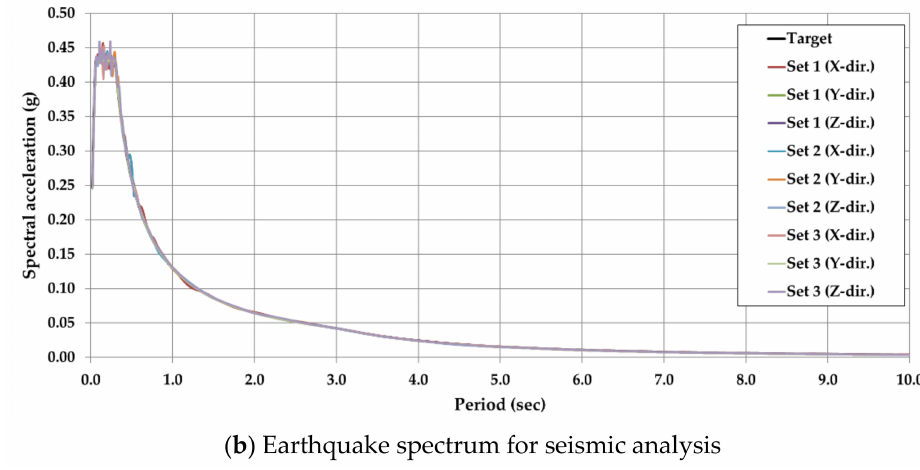
Figure 12. Artificial earthquake generation. ( a ) Artificial earthquake in X-, Y- and Z-directions; ( b ) Earthquake spectrum generation.